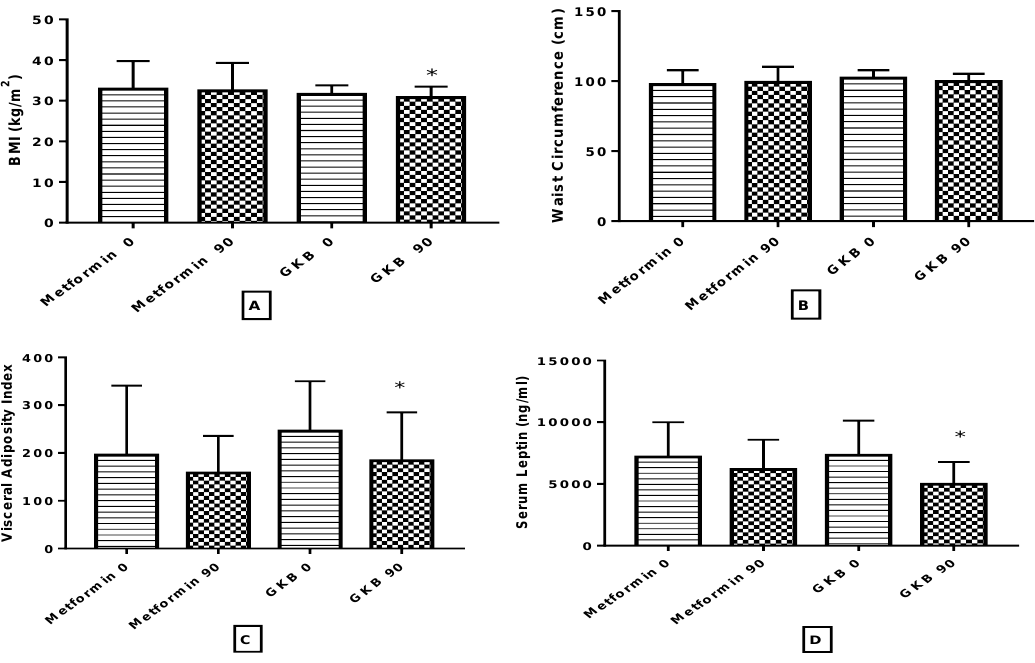
Figure 3. Effect of Gingko biloba extract (GKB) on the serum level of (A) BMI (B) Waist circumference (C) VAI and (D) Leptin of patients with metabolic syndrome. Values were presented as mean ± S.D; * significantly different compared with baseline values (paired t -test, P <0.05). GKB extract (41.3±11.6 vs 30.7±4.8), ( P =0.01) and metformin (49.21±4.4 vs 38.08±3.8), ( P =0.001) compared with the pre-treatment value (Figure